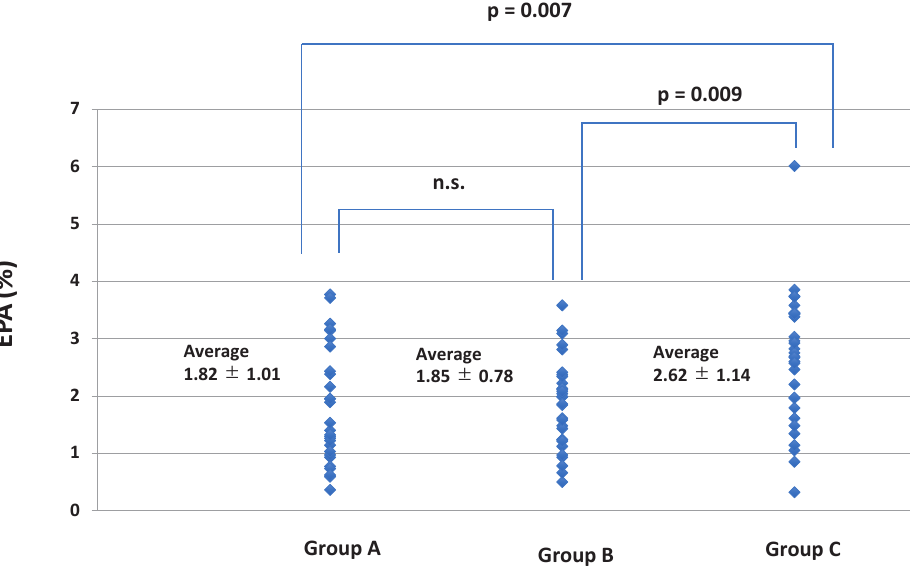
Figure 3. Ratio (%) of EPA in all serum fatty acids in the three